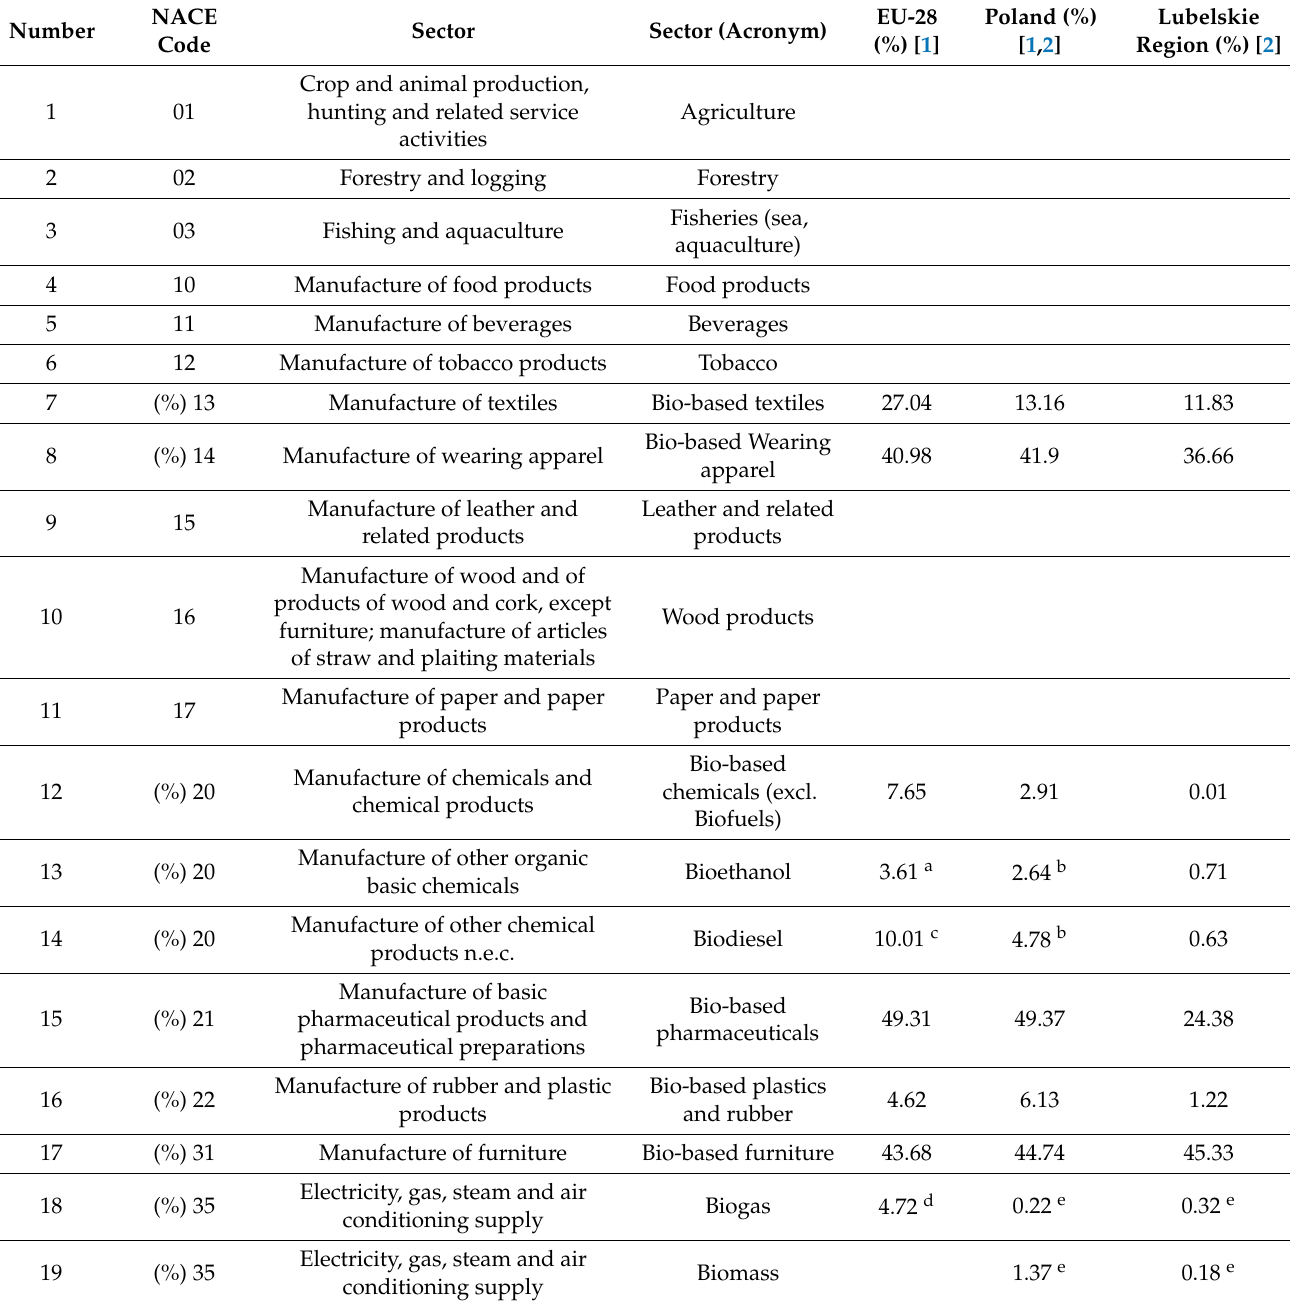
Table 2. Fully and mixed bio-based sectors’ share in Poland and the Lubelskie